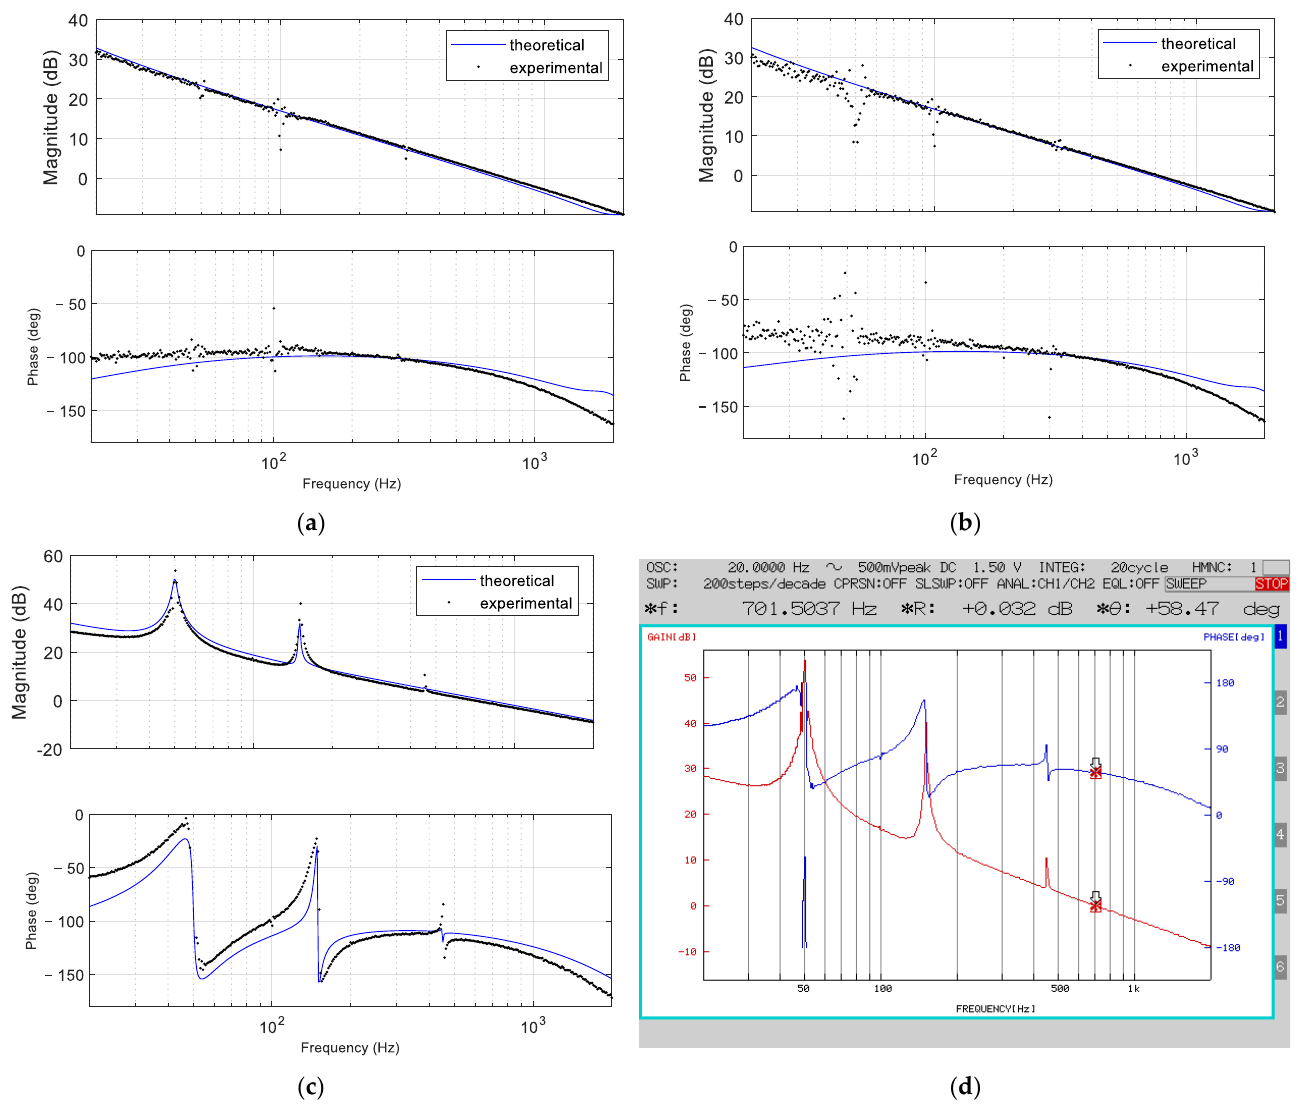
Figure 7. Predicted and measured current control loops gain: ( a ) d -axis, ( b ) q -axis, and ( c ) o -axis. ( d ) Measured current control loop gain in the o -axis where *f stands for the crossover frequency, and *R and * θ for the gain and the phase of the control loop at this